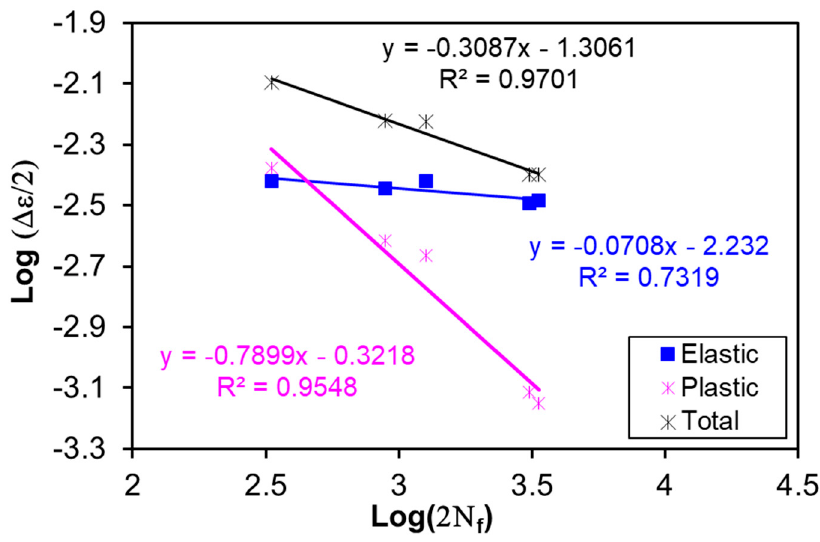
Figure 12. Strain-controlled fatigue life parameters of the heat-treated AlMgSiMnFe alloy.